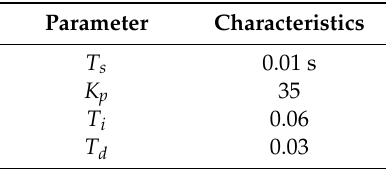
Table A1. PID parameters.